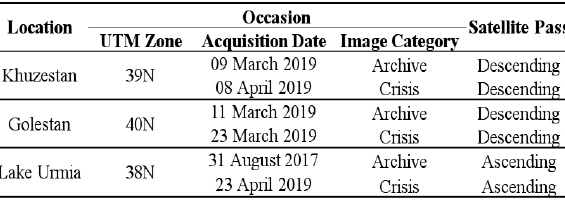
Table 1. Specifications of obtained Sentinel-1 datasets